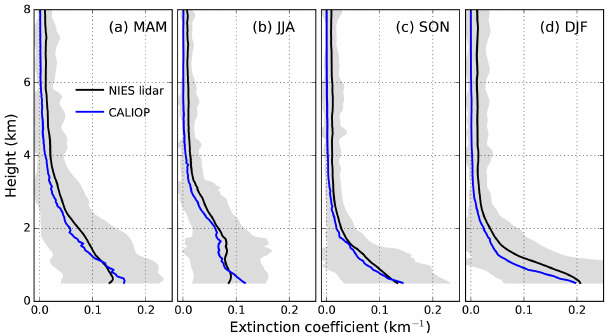
Figure 2. Aerosol extinction coefficient profiles from the ground- based NIES lidar and CALIOP observations over SACOL from Oc- tober 2009 to August 2012: (a) spring; (b) summer; (c) autumn; and (d) winter. Altitudes of CALIOP observations are transferred to heights above the ground level of SACOL. The left and right boundaries of the light grey shadowed area depict the NIES lidar extinction coefficient averages with 1 standard deviation. The NIES lidar aerosol extinction coefficients were derived using an AOD- constrained retrieval method.